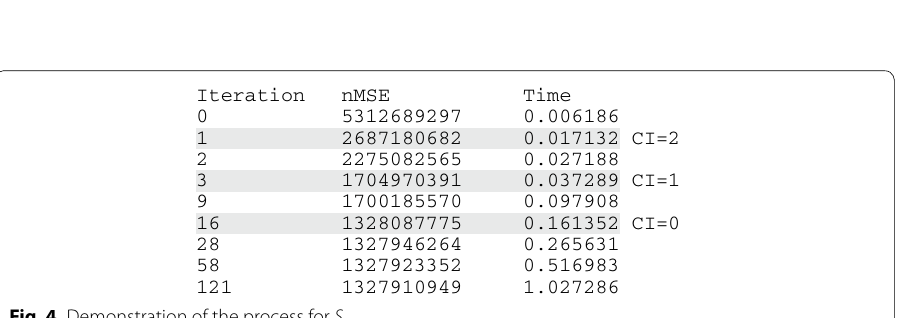
Fig. 4 Demonstration of the process for S